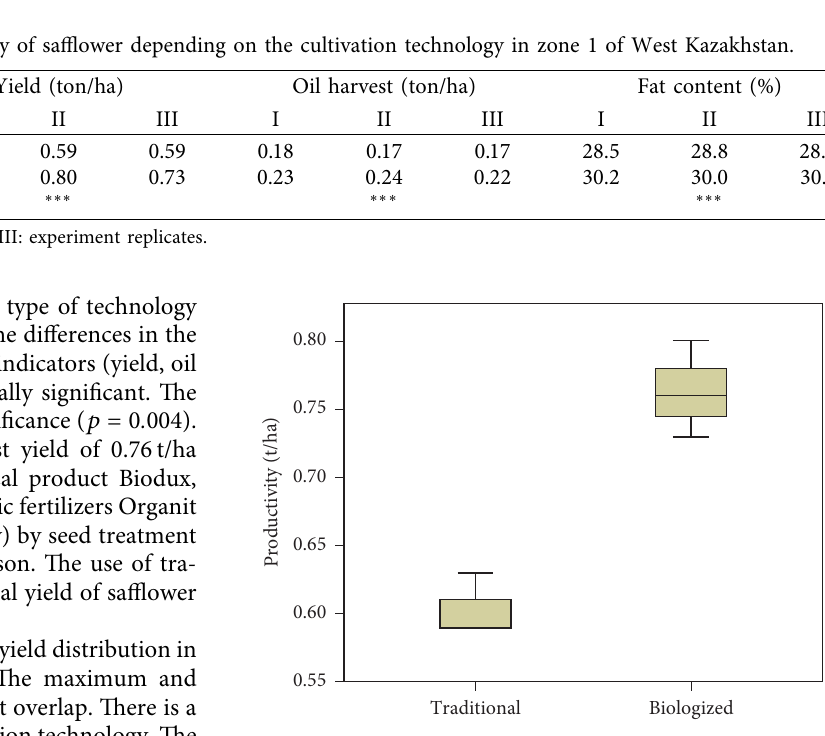
Figure 4: Safflower yield depending on cultivation technology in zone 1 of West Kazakhstan